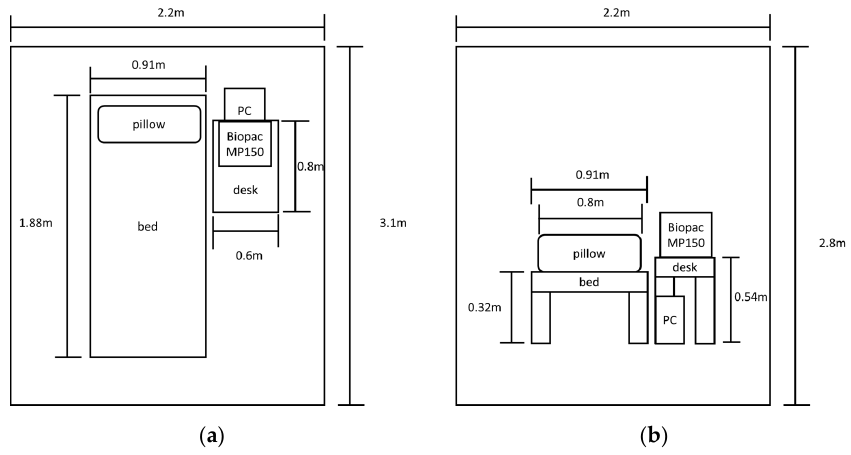
Figure 2. Sleep experimental environment ( a ) plan; ( b ) cutaway view.